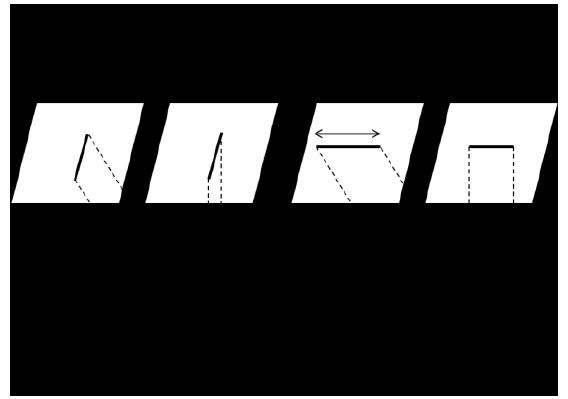
Figure 5. Length of line segment in triplet images The second parameter is color information of both side areas along a line segment. Conventional edge matching is difficult to select corresponded line segment from paralleled edges, as shown in Figure 6. When the line segments have color information along their lines, image matching, such as template matching, can be applied to line segments to avoid of uncertainty in the edge matching.